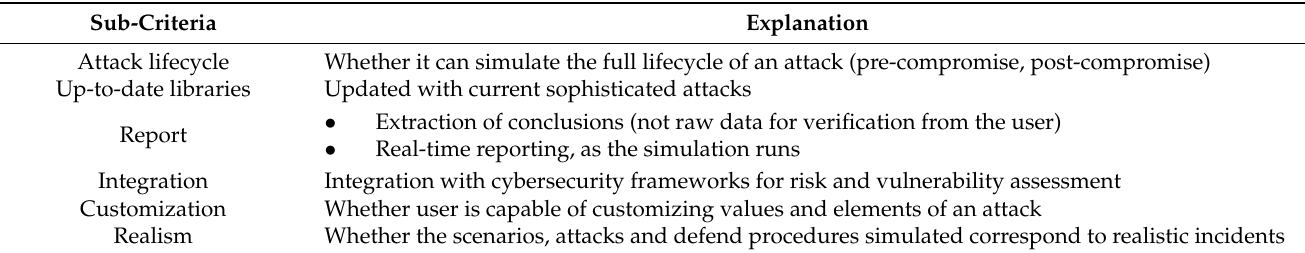
Table 2. Additional criteria for selection/rejection of cybersecurity simulation